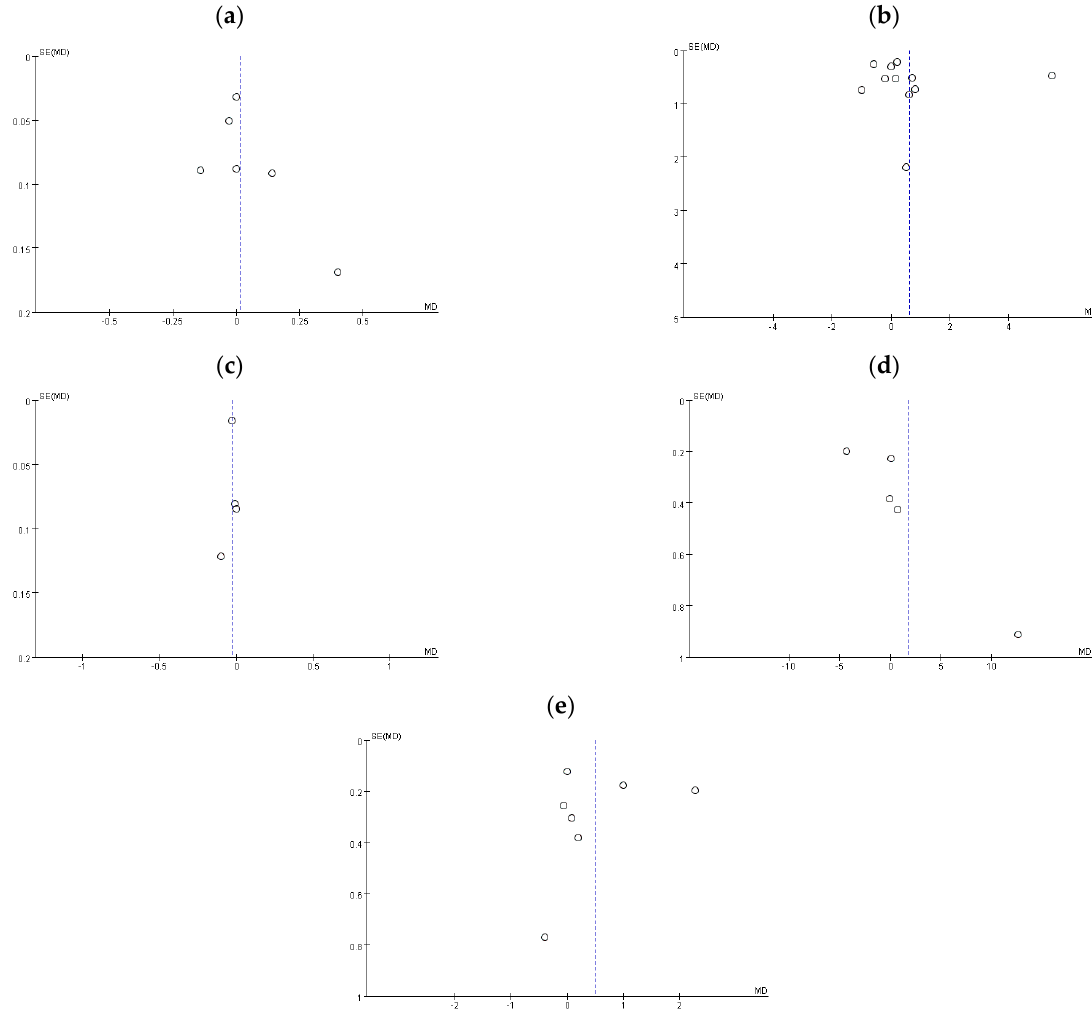
Figure 4. Funnel plot: ( a ) skeletal muscle mass index, ( b ) hand grip strength, ( c ) 4 m gait speed, ( d ) chair rise test, and ( e ) SPPB.